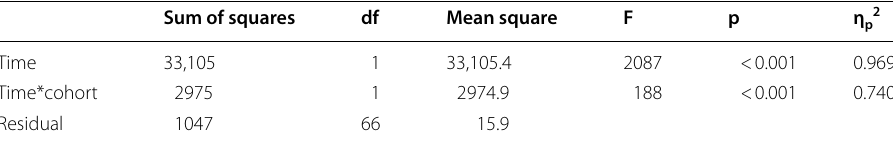
Type 3 sums of squares